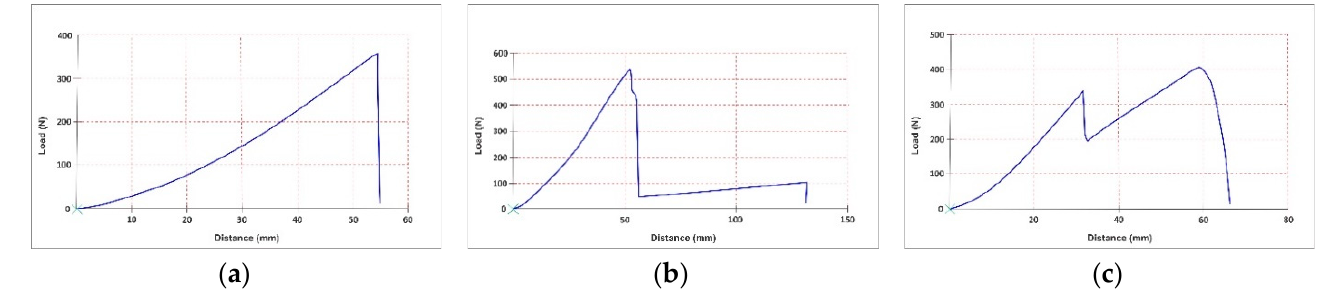
Figure 8. Tensile curve for perforated samples: ( a ) calfskin (M1); ( b ) calfskin with PES knitted fabric lining (M1 + M2); and ( c ) calfskin with sheep leather lining (M1 + M3).